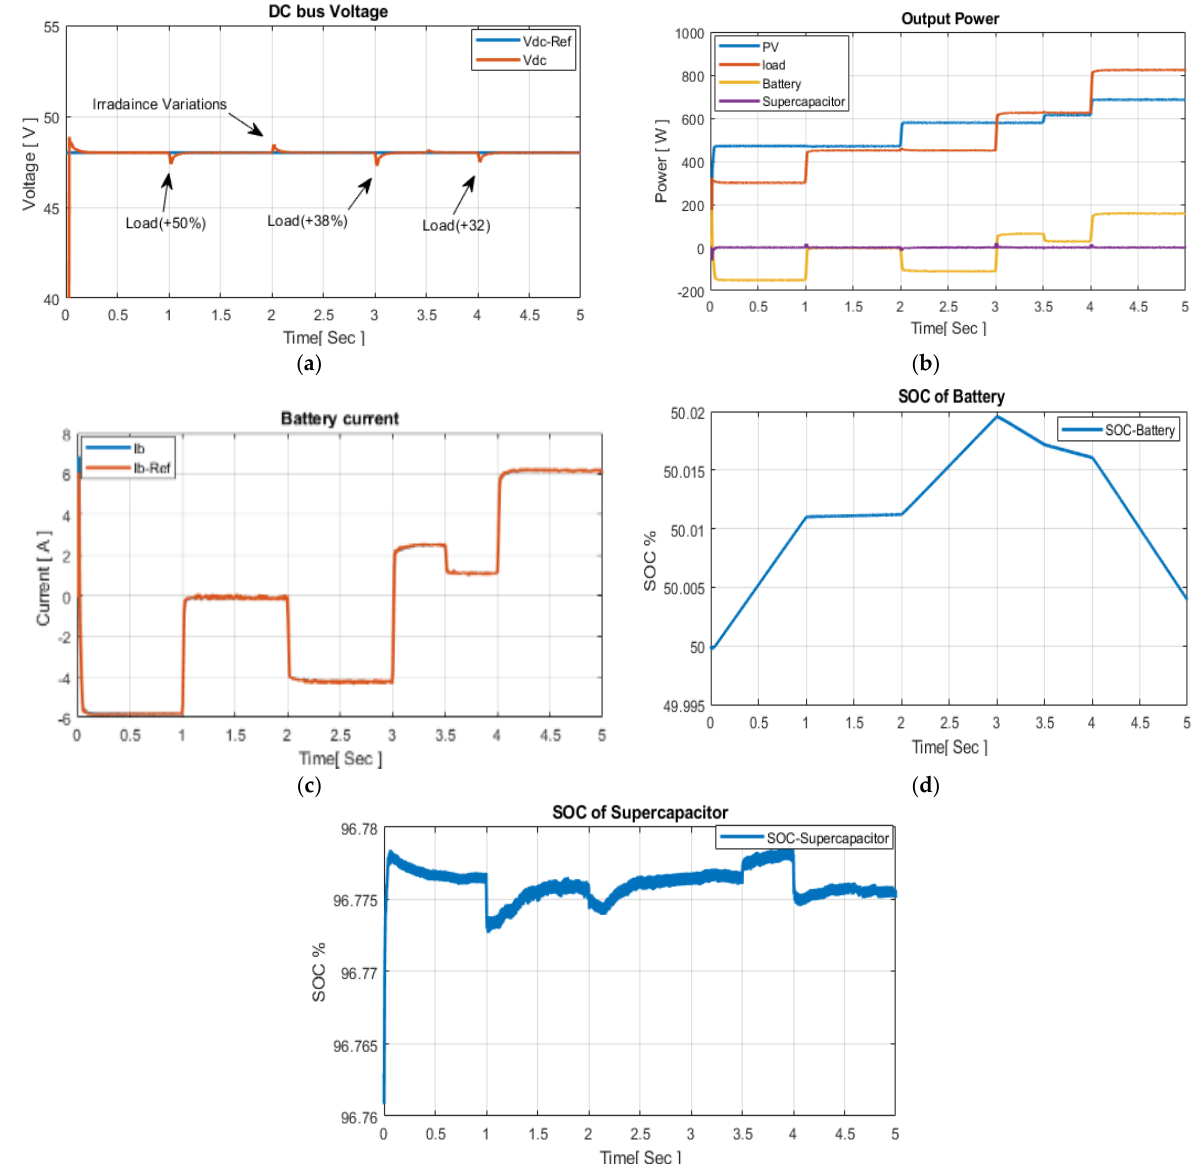
Figure 7. Results with the hybrid PSO–GWO: ( a ) DC-link voltage; ( b ) power exchange; ( c ) battery current; ( d ) SOC of battery; ( e ) SOC of supercapacitor.